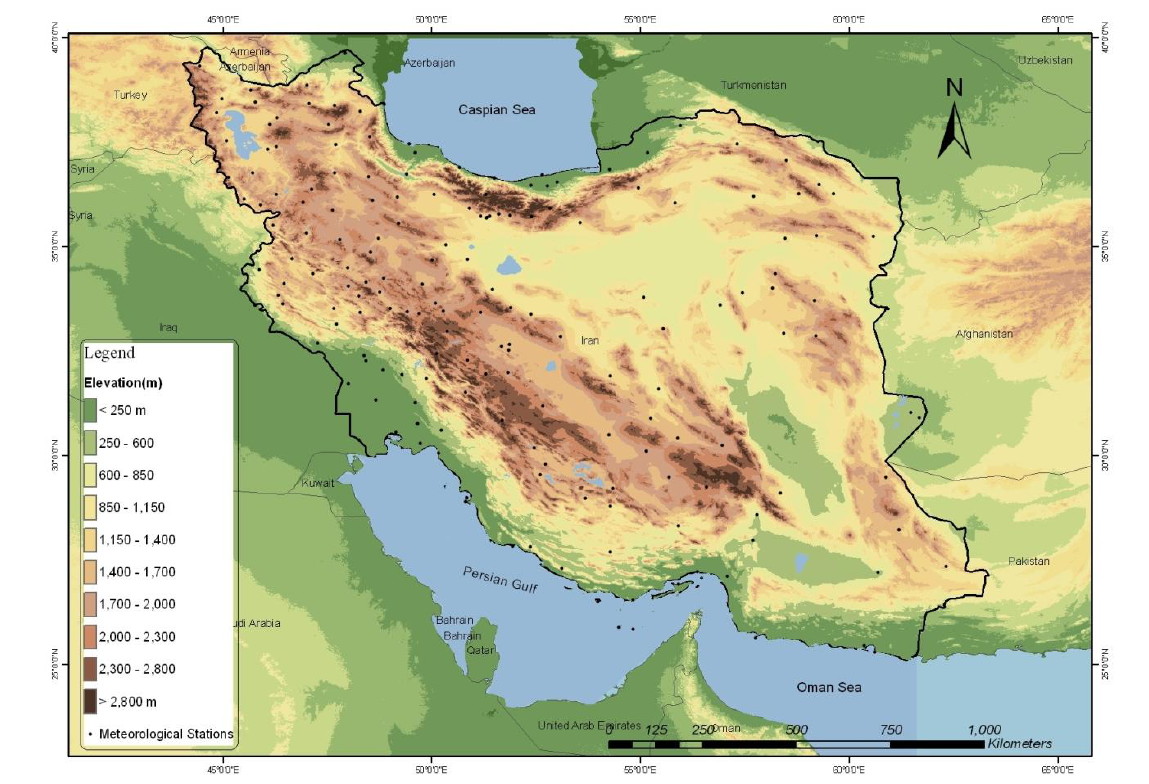
Figure 1. Geographical location and topographic map of Iran and spatial distribution of meteorological